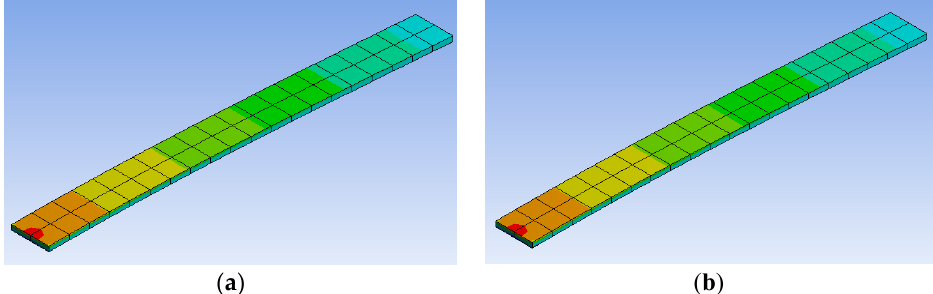
Figure 5. Stress distribution picture of the flat spring under the different applied load ( a ) 4.63 N; ( b ) 1.74 N.